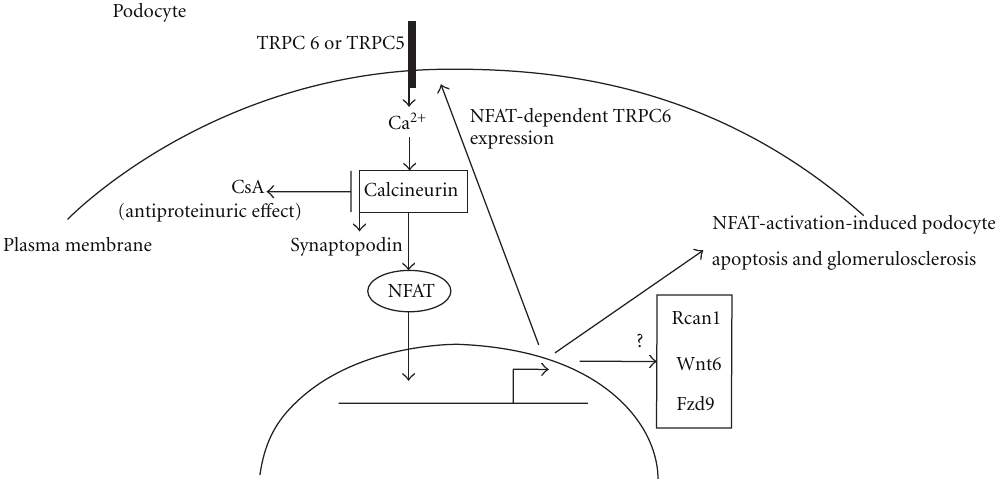
Figure 1: The calcineurin-activation-induced podocyte injury. Upon activation by increased intracellular Ca 2+ , calcineurin dephospho- rylates the NFAT proteins and synaptopodin [5, 6]. NFAT activation induces podocyte apoptosis [11] and glomerulosclerosis [6]. TRPC6- mediated Ca 2+ influx stimulates NFAT-dependent TRPC6 expression [7]. Rcan1, Wnt6, and Fzd9 were shown to be upregulated in glomeruli isolated from NFATc 1 nuc transgenic mice, making them potentially direct targets of NFAT